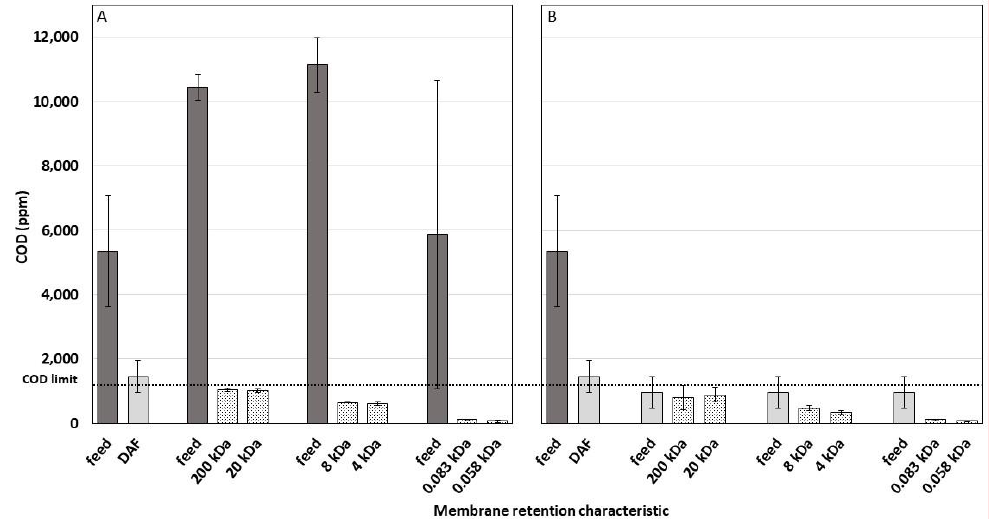
Figure 5. Chemical Oxygen Demand (COD) of the feed and permeate stream of different membranes in ( A ) membrane filtration and ( B ) post-DAF membrane filtration experiment.